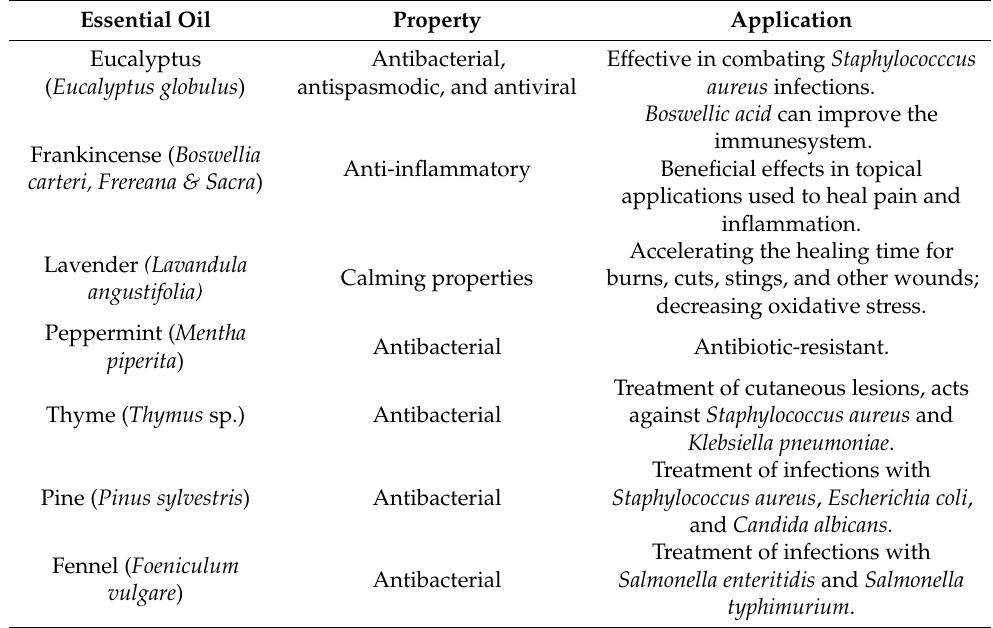
Table 1. Essential oils: properties and applications